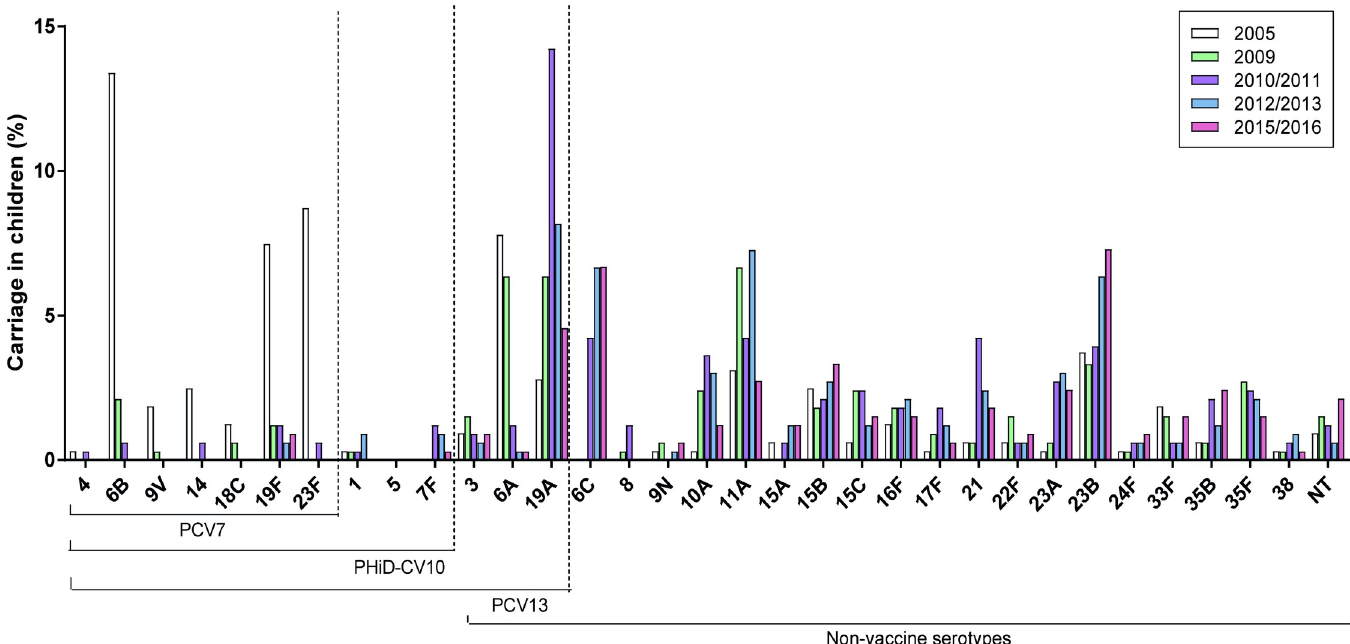
Fig 2. Serotype distribution in 24-month-old children carrying S . pneumoniae . The first bar (2005) depicts carriage prevalence before implementation of PCV. The following four bars depict carriage prevalence as observed during the follow-up studies; respectively 3 years after PCV7 implementation (2009), 4.5 years after PCV7 implementation and immediately before introduction of PHiD-CV10 (2010/2011), 1.5 years after PHiD-CV10 implementation (2012/2013) and 4.5 years after PHiD-CV10 implementation